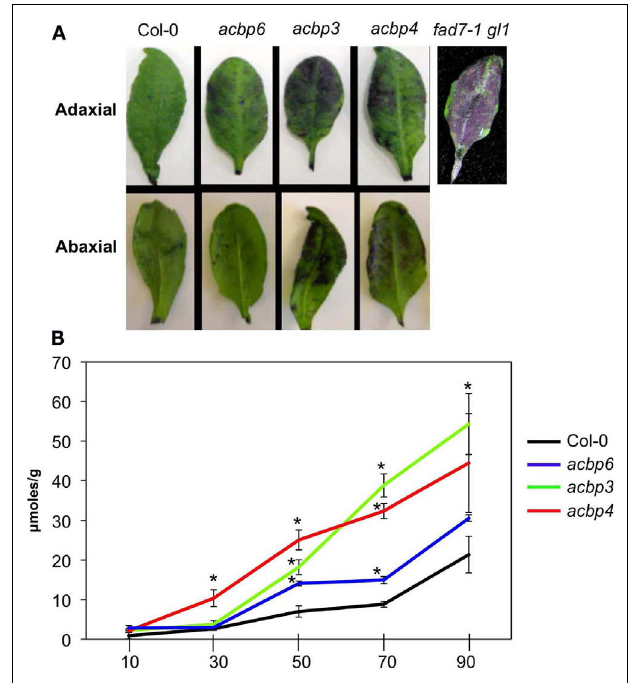
FIGUREA3 | Cuticular phenotypes of acbp plants. (A) Whole leaf toluidine blue staining. Leaves were incubated in the stain for 10min and the experiment was repeated four times with similar results. (B) A time-course measurement of chlorophyll leaching in various genotypes at indicated times.The values are presented as a mean of four replicates.The error bars represent SD ( P < 0.05).The experiment was repeated four times.